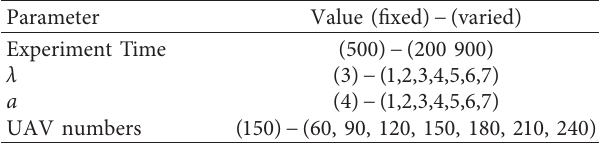
Table 2: Parameters for experiment